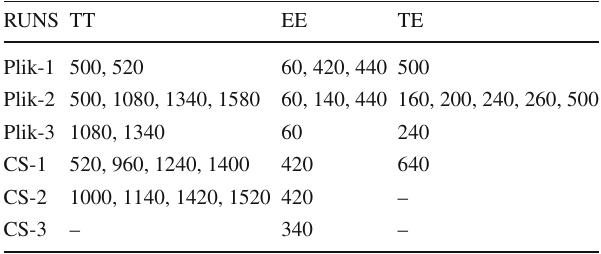
Table 5 Outliers addressed by the Plik-bin1 (first three) and CamSpec clean (last three) candidates from the residual plots of TT, EE and TE correlation in Figs. 4 and